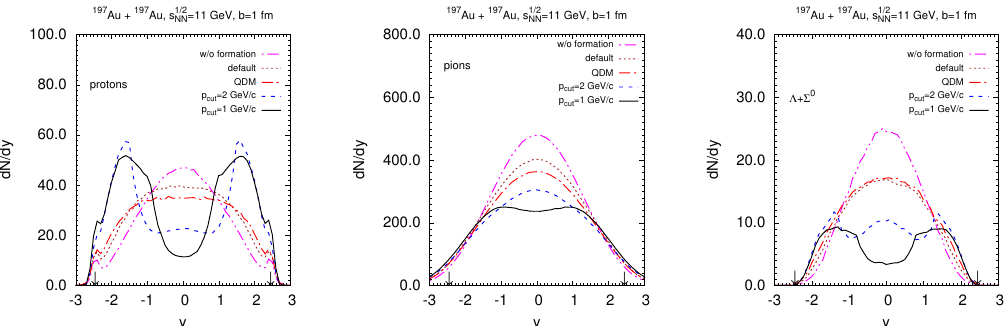
Figure 7. Rapidity spectra of protons, pions and neutral hyperons produced in minimum bias √ s NN = 11 GeV. Different lines show p+Au collisions and central ( b = 1 fm) Au + Au collisions at calculations with different prescriptions for hadron formation (line notations are the same as in Figure 5). Arrows show rapidities of the projectile and target in the laboratory frame.